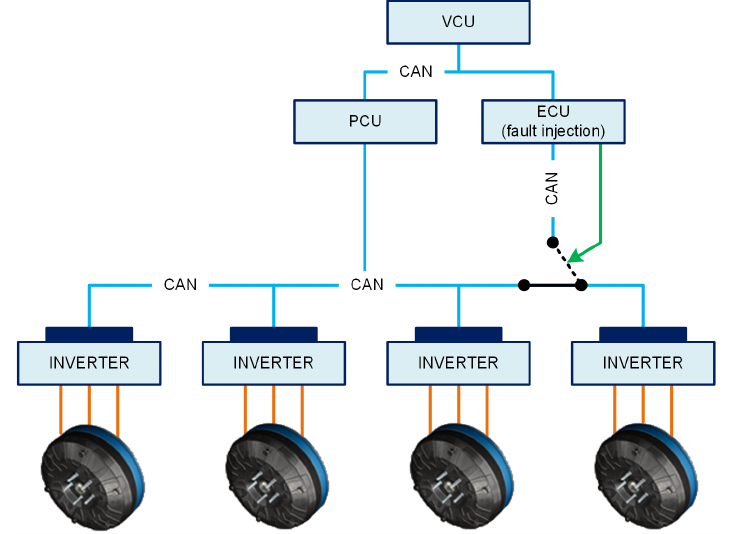
Figure 12. XILforEV configuration for fail-safe and robustness